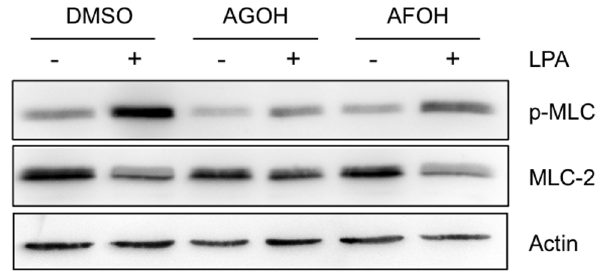
Figure 7. PFIs block p-MLC downstream of Rho signaling in MDA-MB-231 cells. MDA-MB-231 cells were treated with 100 m M AGOH and 20 m M AFOH for 3 days, plated on collagen I coated dishes, and then treated with 100 nM LPA for 5 min. Cell lysates were immunoblotted with p-MLC. Total MLC-2 and b -actin serve as the loading